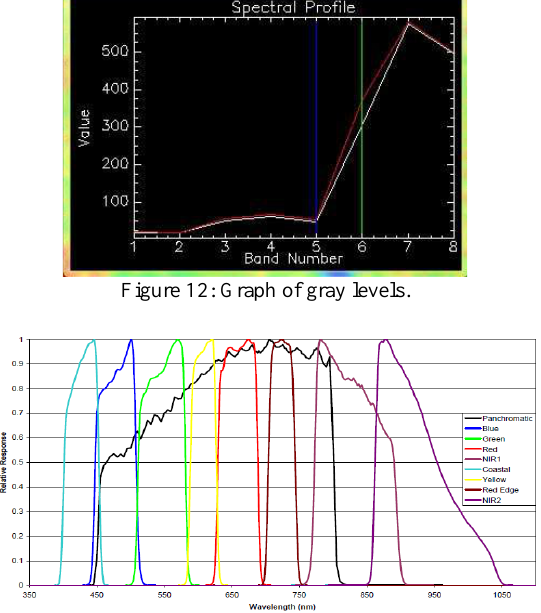
Figure13 – Spectral response of WorldView-2